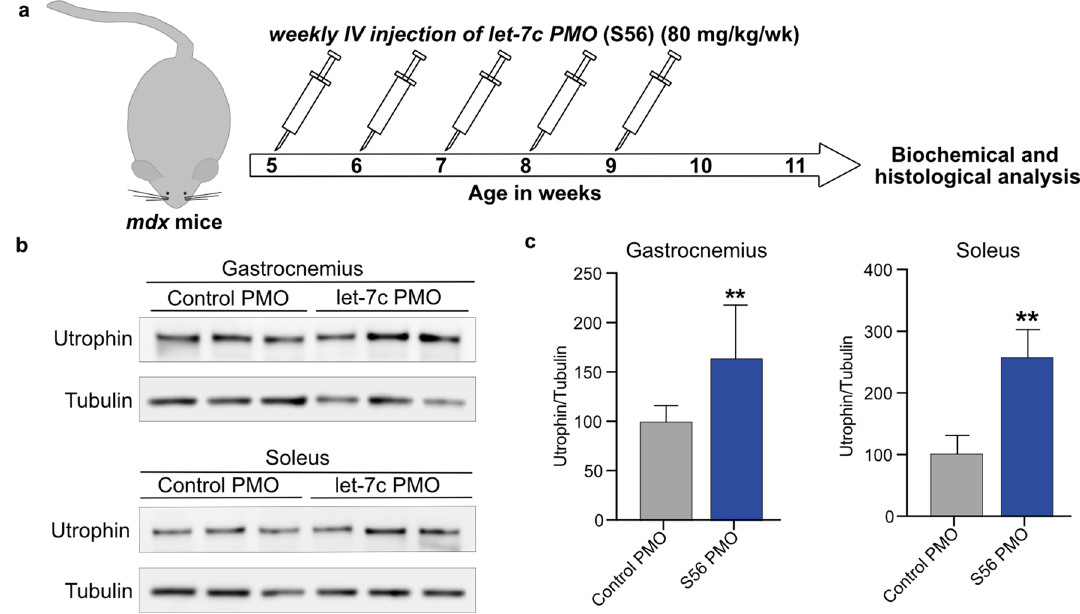
Figure 3. Higher expression of utrophin in mdx mice after five weeks of treatment with 80 mg/kg/wk S56 PMO. ( a ) Diagram of the experimental pipeline adopted for the study. ( b ) Western blot showed higher level of utrophin expression in gastrocnemius and soleus muscles of S56 PMO treated mdx mice. Samples from three different mdx mice treated with control or S56 PMO were shown. ( c ) Quantification of normalized utrophin level in control and S56 PMO treated mdx mice gastrocnemius and soleus muscle (n = 6 mice for both groups). Data shown as percentage of normalized utrophin level compared to control PMO treated mdx mice. Each bar represents mean ± SEM. Statistical analysis performed by Mann–Whitney nonparametric test, ** p <